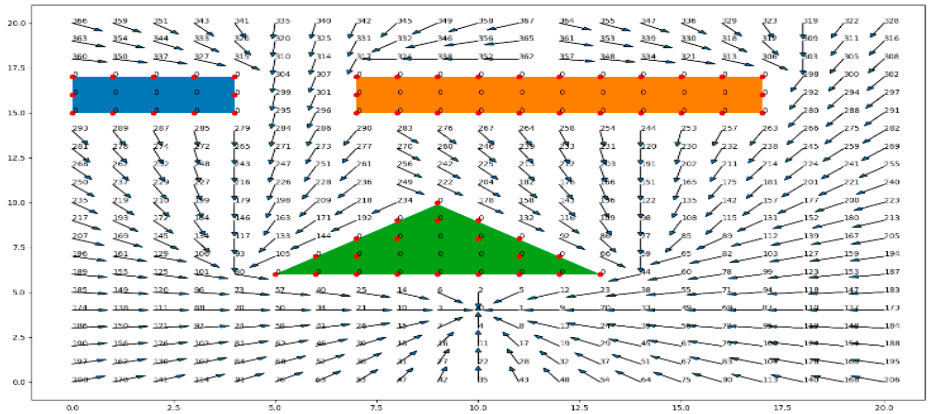
Figure 10. The visitation order and optimal moving vector fields of the map.